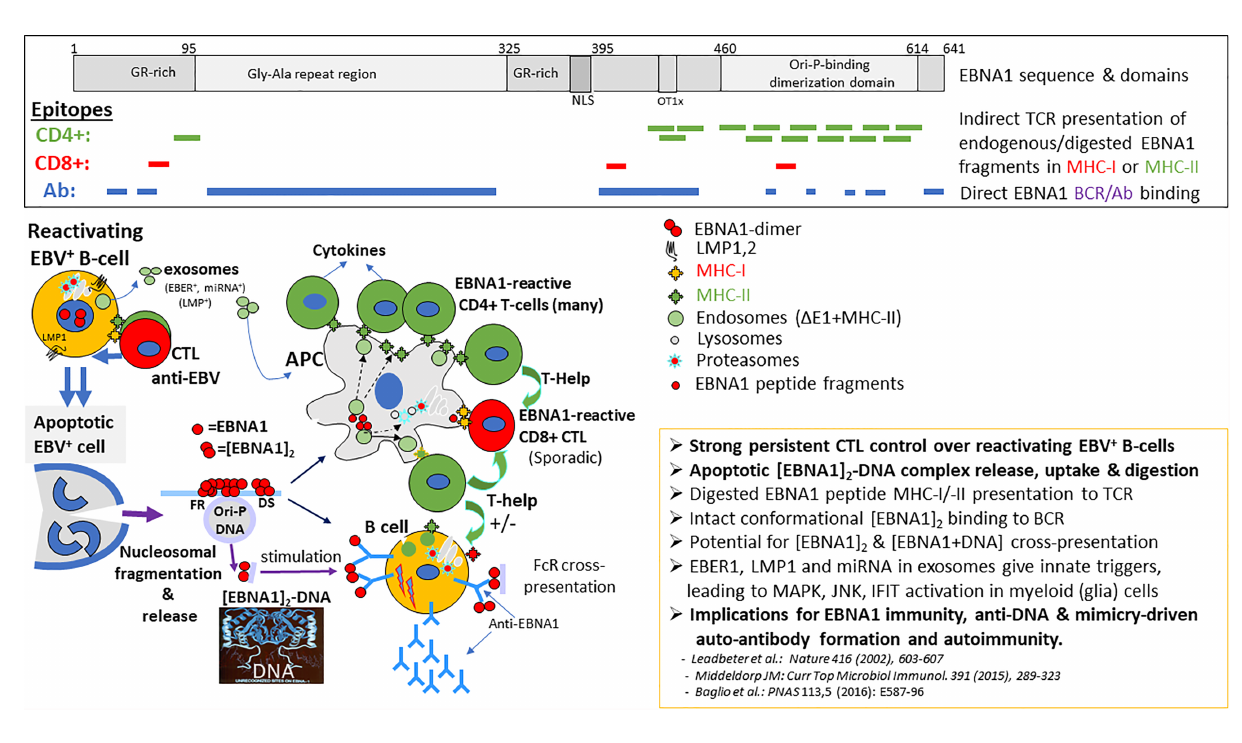
FIGURE 2 | Processing, presentation and position of EBNA-1 epitopes for CD4+, CD8+ T-cells and antibodies (B-cells). Viable persistent and “ reactivating ” EBV infected B-cells secrete EBER1 and LMP1 containing exosomes in the head & neck lymphoid microenvironment, continuously activating resident myeloid cells (possibly including microglia and astrocytes) for innate in fl ammatory signaling and increased antigen-uptake, digestion and presentation. Such innate signals may attract and pre-activate T- and B-cells to the in fl ammatory site. In EBV carriers, lifelong strong adaptive CD4+ and CD8+ cytotoxic T-cell immunosurveillance exists against replicating latent (Latency-I,-II,-III) and reactivating (Latency-III, Lytic) EBV-infected B-cells recognizing viral peptides bound to surface MHC-I or MHC-II molecules, resulting in release of pro-in fl ammatory cytokines. This T-cell surveillance is causing repetitive apoptotic cell death of EBV-infected cells and release of nuclear content as apoptotic bodies, enhancing the local in fl ammatory milieu. Such apoptotic bodies contain EBNA1-DNA (and host protein) complexes which are taken-up by antigen-presenting cells (APC), digested and presented in MHC-II for further CD4+ T-help and cytokine activation. EBNA1-dimers and multimeric EBNA1-DNA complexes also bind to the B-cell receptor (BCR) on B-cells, directly triggering anti-EBNA1 antibody responses, supported by local CD40 T-cell interactions and cytokines (IL4, IL10, IL17A). Prevalent anti-EBNA1 antibodies may form (complement-containing) immune complexes with released EBNA1-dimer/- DNA resulting in Fc-receptor (FcR) uptake into APC ’ s and processing for MHC-II cross-presentation. Binding to B-cell receptor (IgM-IgD) directly triggers anti-EBNA1 antibody responses and possible anti-self autoimmune responses mediated by EBNA1-bound DNA and host nuclear proteins (i.c. ORC-complex) or via the mimicry domains within the EBNA1 sequence (see Table 1